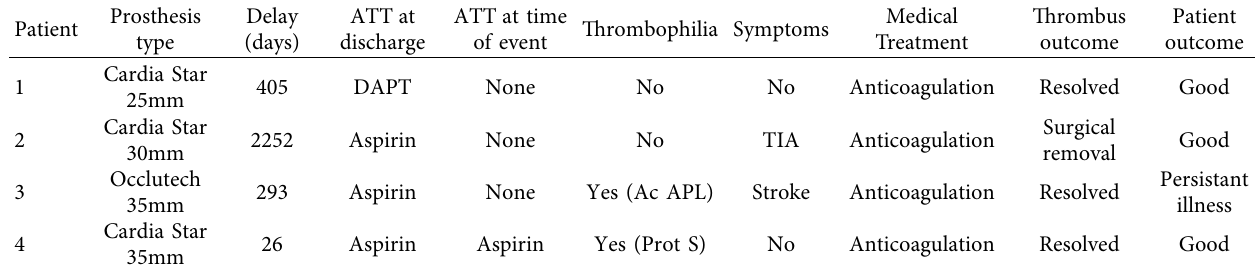
Table 5: Details of thrombotic deposits on the PFO prosthesis.